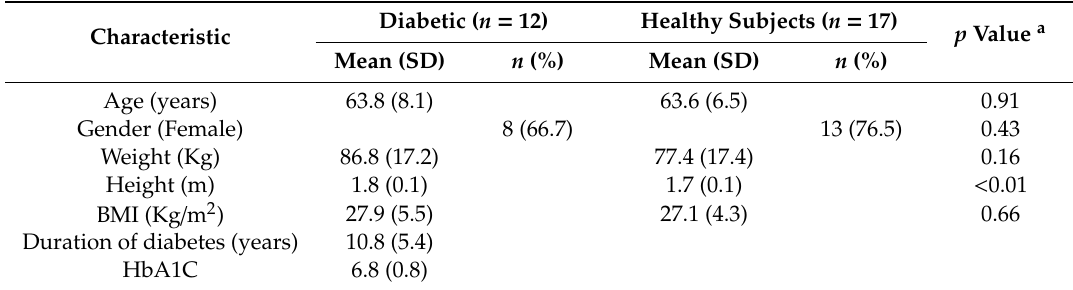
Table 1. Demographic characteristics of participants ( N =